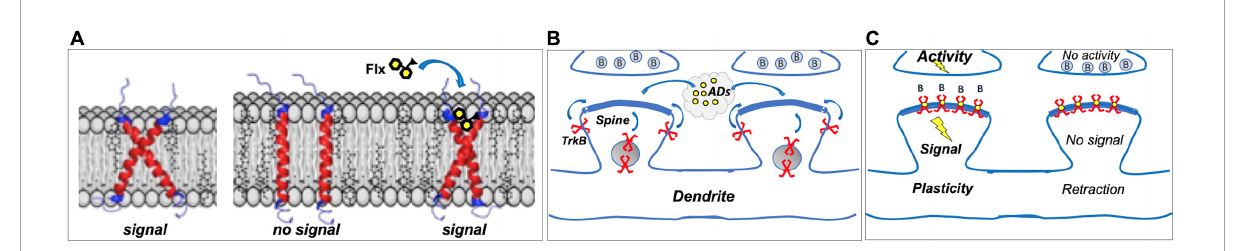
FIGURE1 (A) Dimers of TrkB transmembrane domains (TMD) assume a crossed signaling-competent structure; in thick cholesterol-rich synaptic membranes, crossed structure becomes instable, and TrkB is excluded from synapses. Binding of fluoxetine (Flx) to the crossed TMDs acts as a wedge, stabilizing the signaling-competent structure in synaptic membranes. (B) Most TrkBs reside in vesicles or outside synapses; antidepressants (ADs) promote synaptic localization. (C) In Hebbian plasticity, active synapses are stabilized, whereas inactive ones are retracted, and brain-derived neurotrophic factor (BDNF) through TrkB is a critical mediator in this process. Antidepressants act as positive allosteric modulators of TrkB, promoting its localization in synaptic membranes where it can bind BDNF (B) released from stimulated synapses, enhancing TrkB signaling and stabilizing active synapses. Inactive synapses, however, do not release BDNF to activate synaptic TrkB receptors, which gradually leads to spine retraction. Direct TrkB agonist would activate TrkB in both active and inactive synapses, gradually leading to the decline in activity-dependent